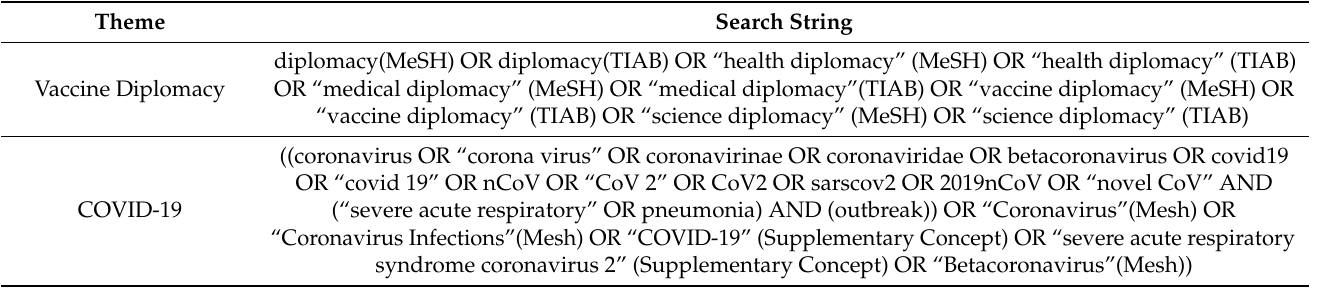
Table 1. PubMed and Medline search strategy.